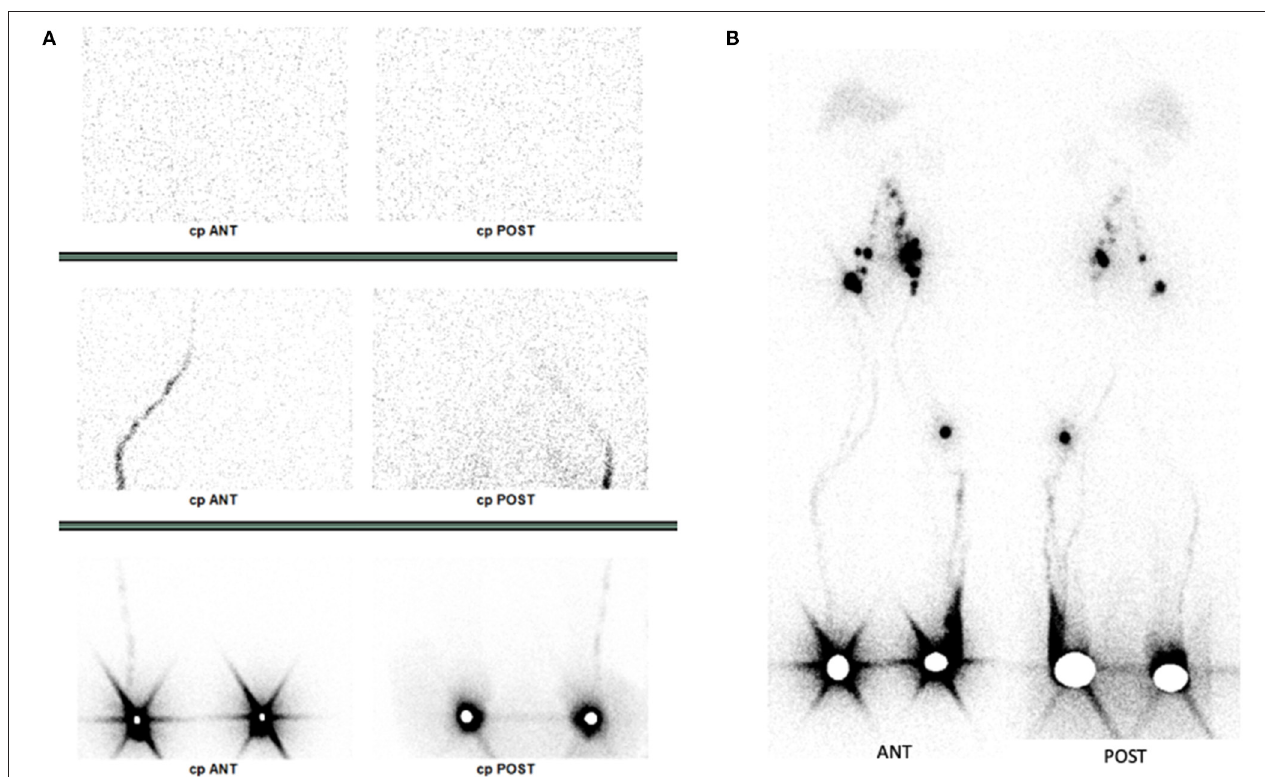
FIGURE 1 | Dual-head conventional camera results. Early anterior and posterior static planar images (A) , late anterior and posterior whole-body planar images (B) .